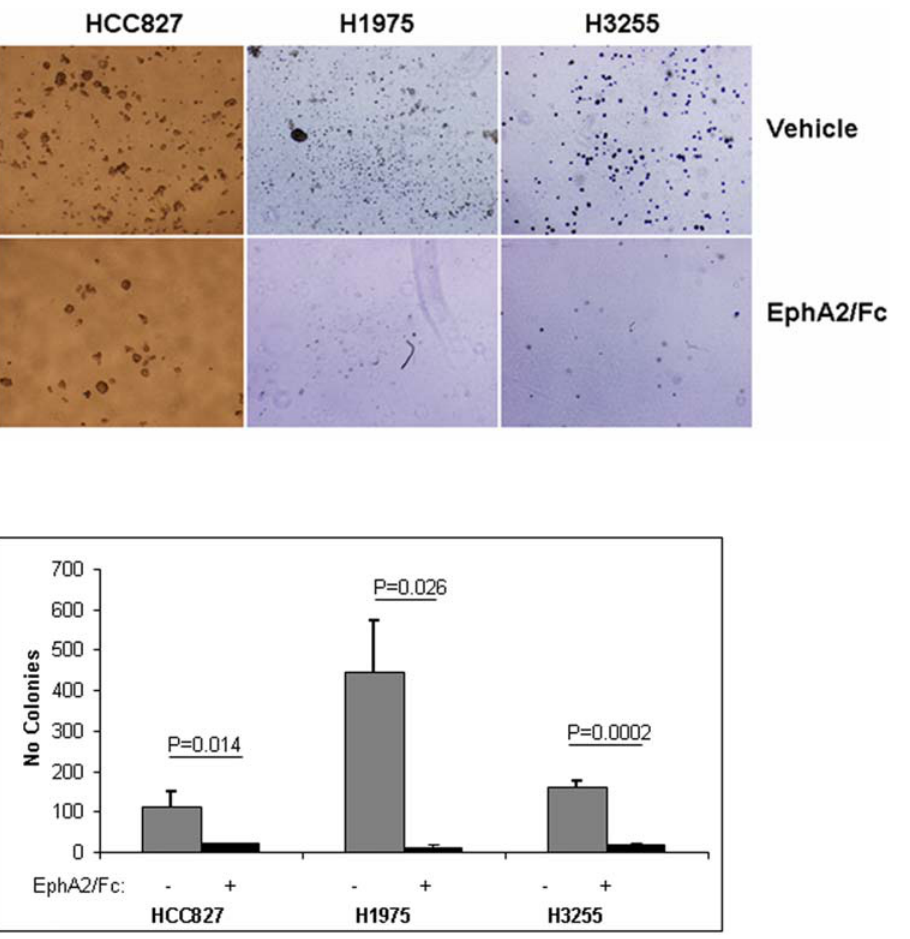
Figure 8. EphA2-Fc inhibits NSCLC anchorage-independent growth. Representative images of colonies of NSCLC cell lines (top) with quantification of colonies (bottom) after growth in soft agar in the presence or absence of EphA2-Fc. Results are the means of at least three independent experiments.